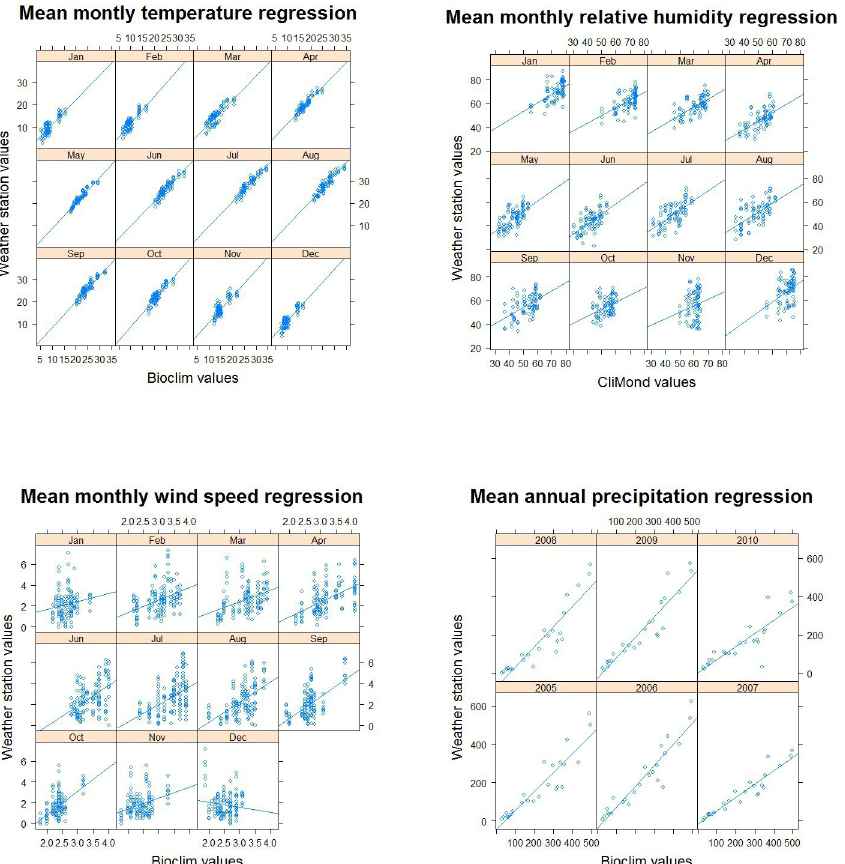
Fig 3. Data validation regression plots. Results from simple linear regression analysis between weather station climate data recordings and modelled climate data using historical recordings for (A) mean monthly temperature, (B) mean monthly relative humidity, (C) mean monthly wind speed, and (D) mean annual